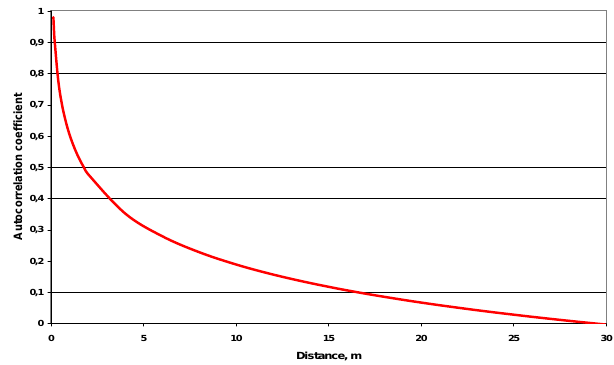
Fig. 14. Theoretical multifractal autocorrelation function derived by using the best-fitting straight line in Fig. 13. For lag distances h ≥ 2m, autocorrelation coefficients approximately satisfy Eq. (9); for h< 2m, the model indicates a nugget effect with shape of auto- correlation function resembling hypothetical curve of Fig. 12.